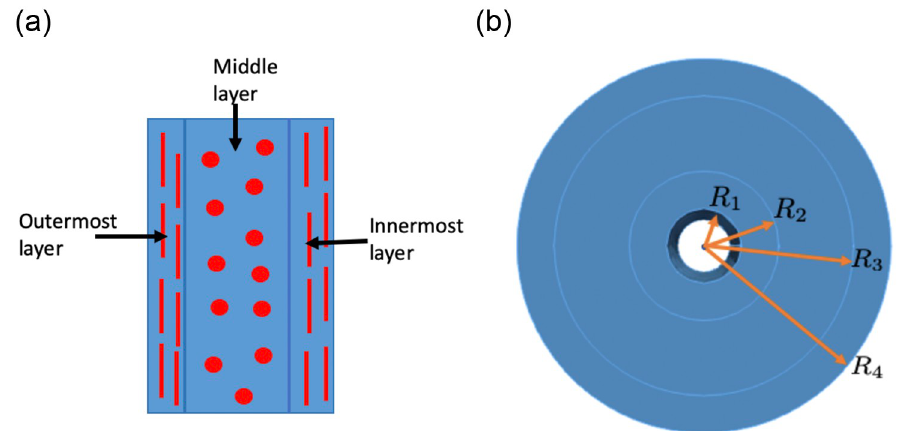
Fig 2. Simple illustrations of the three-layered cervix and its fiber distribution. The left panel (a) illustrates half of an axial cross section of the cervix with different fiber orientations in each layer. The vertical line sections in the innermost and outermost layers illustrate collagen fibers oriented axially, whereas the dots in the middle layer illustrate collagen fibers oriented circumferentially (perpendicular to the axial cross section). The right panel (b) illustrates a transverse section of the cervix with three layers showing the radius prescription for the boundaries and interfaces of the three-layered cervix.